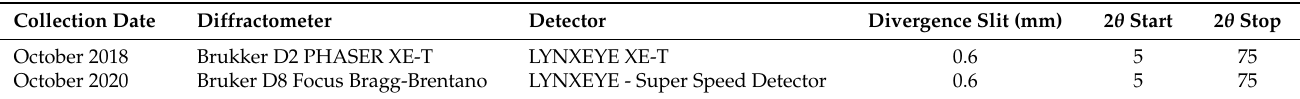
Table A2. XRD details for the October 2018 and October 2020 ground surveys. October 2020 soil samples were crushed to a fine powder using a large metal mortar and